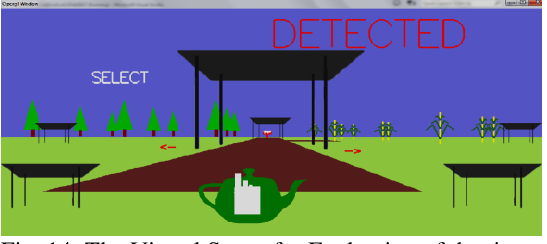
Fig. 14: The Virtual Scene for Evaluation of the time